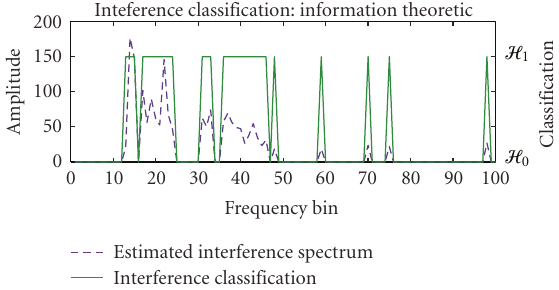
Figure 5: An example interference classification produced using the radiometer method. The classification should be compared against reference sample vector interference spectrum shown in Figure 2. In this example, this method failed to detect the low power interferer occupying frequency bins 64 through to 77, but otherwise produced an accurate classification.